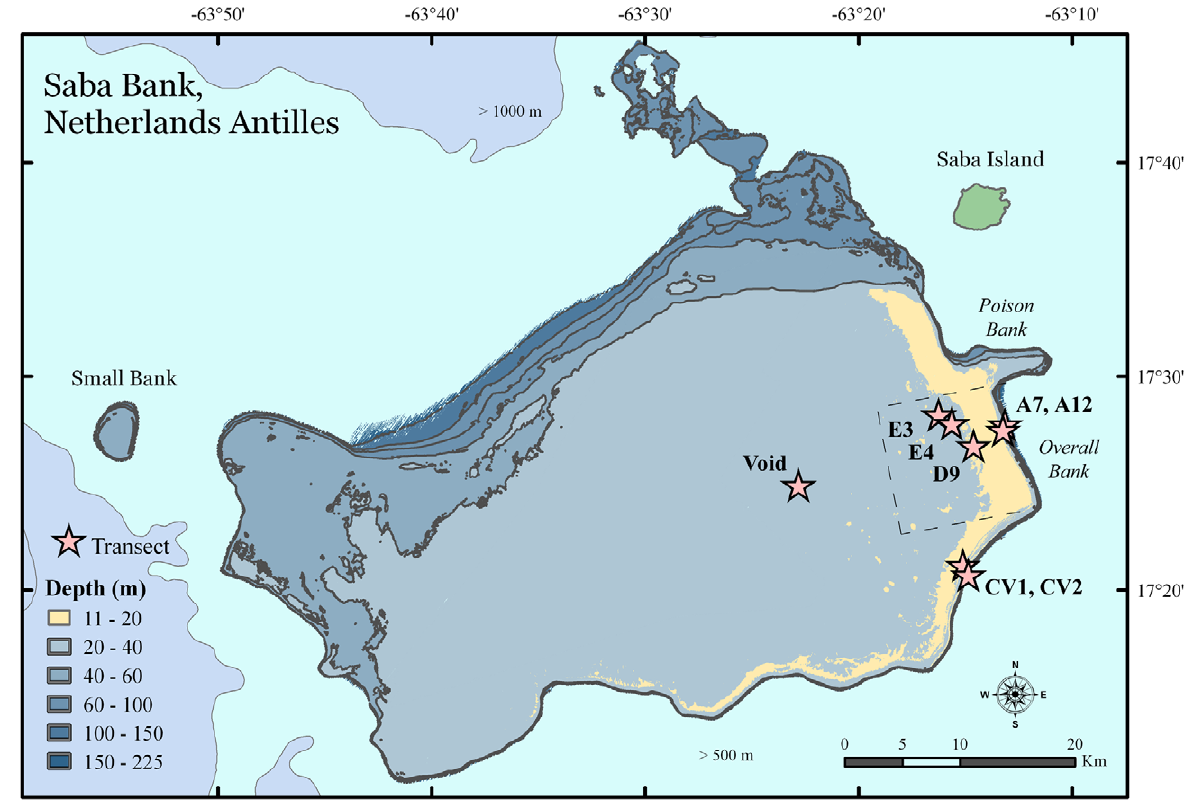
Figure 1. A map of Saba Bank, in the Netherlands Antilles. Saba Bank is shown relative to its nearest neighbor, Saba. A pale band of color representing 11–20 m depths represents a ‘‘fore-reef’’ extending 50 km along the southeast perimeter of the Bank. Red stars indicate the location of 8 quantitative transects, four on the fore-reef (A sites and CV sites) and four in the plateau (E3, E4, D9, Void) of Saba Bank’s interior region. The dashed lines indicate Overall Bank, where a zonation scheme with random sites was in effect. Void was random, Conch Valley was non-random.